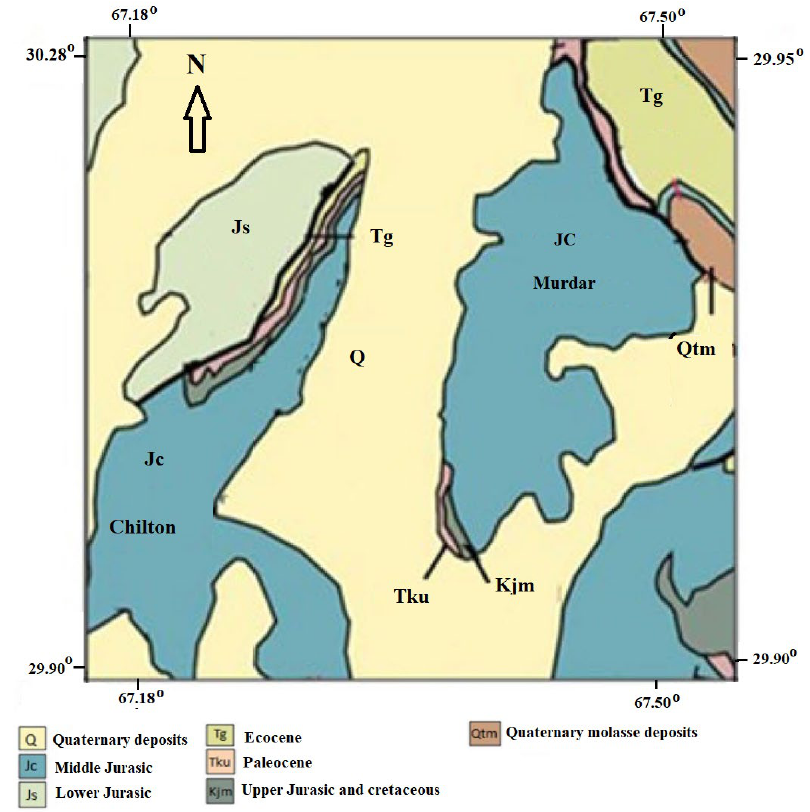
Figure 2. Geological map of the study area .